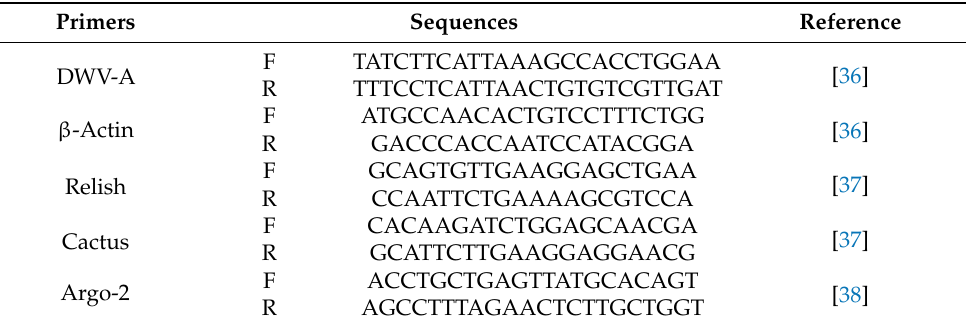
Table 1. Nucleotide sequence of defense gene primers from Apis mellifera and deformed wing virus (DWV-A) used in